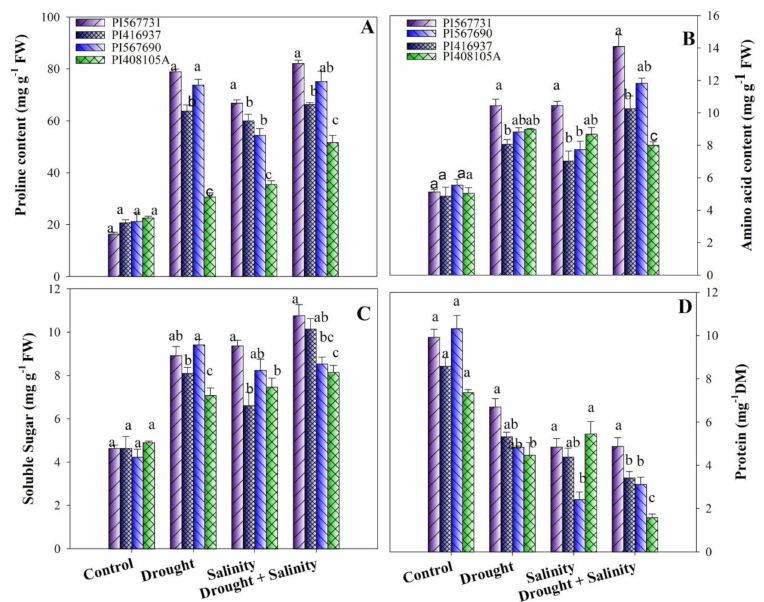
Figure 5. ( A ) Proline, ( B ) free amino acids, ( C ) soluble sugars, and ( D ) protein of four soybean cultivars grown under drought and salinity stress conditions. Data presented are means ± SD, and different letters denote a significant difference at p < 0.05 based on the least significant difference (LSD) test. Letter a is highly significant than b, and ab means no significant differences between a with ab and b with ab.